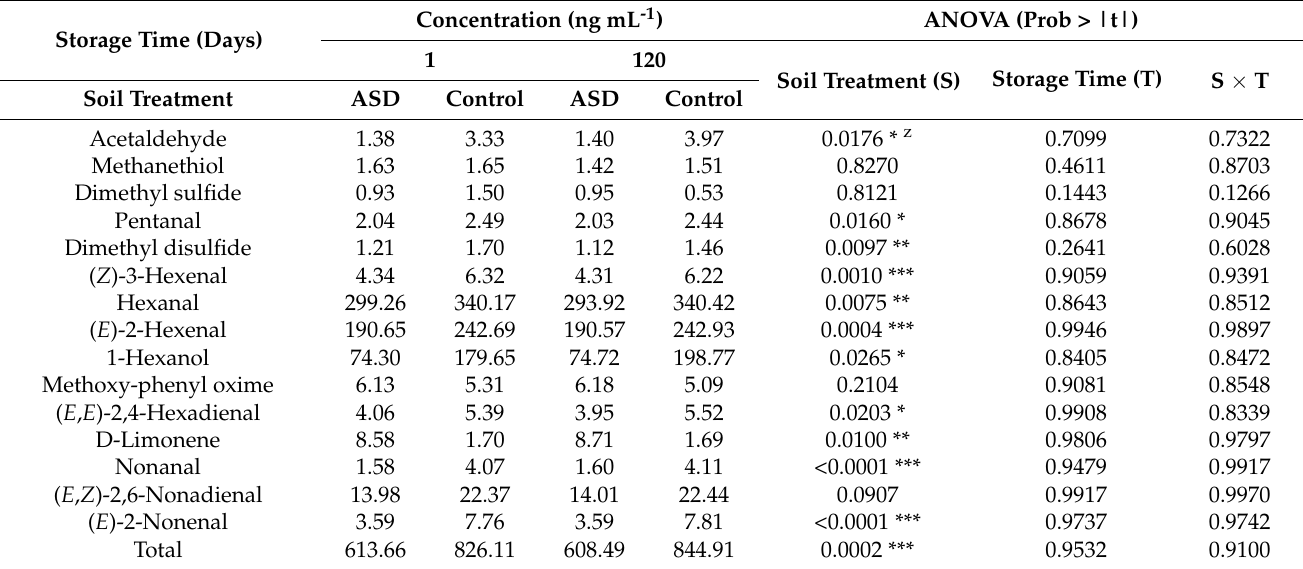
Table 5. Effect of soil treatment and storage time on volatile profile of winter melon